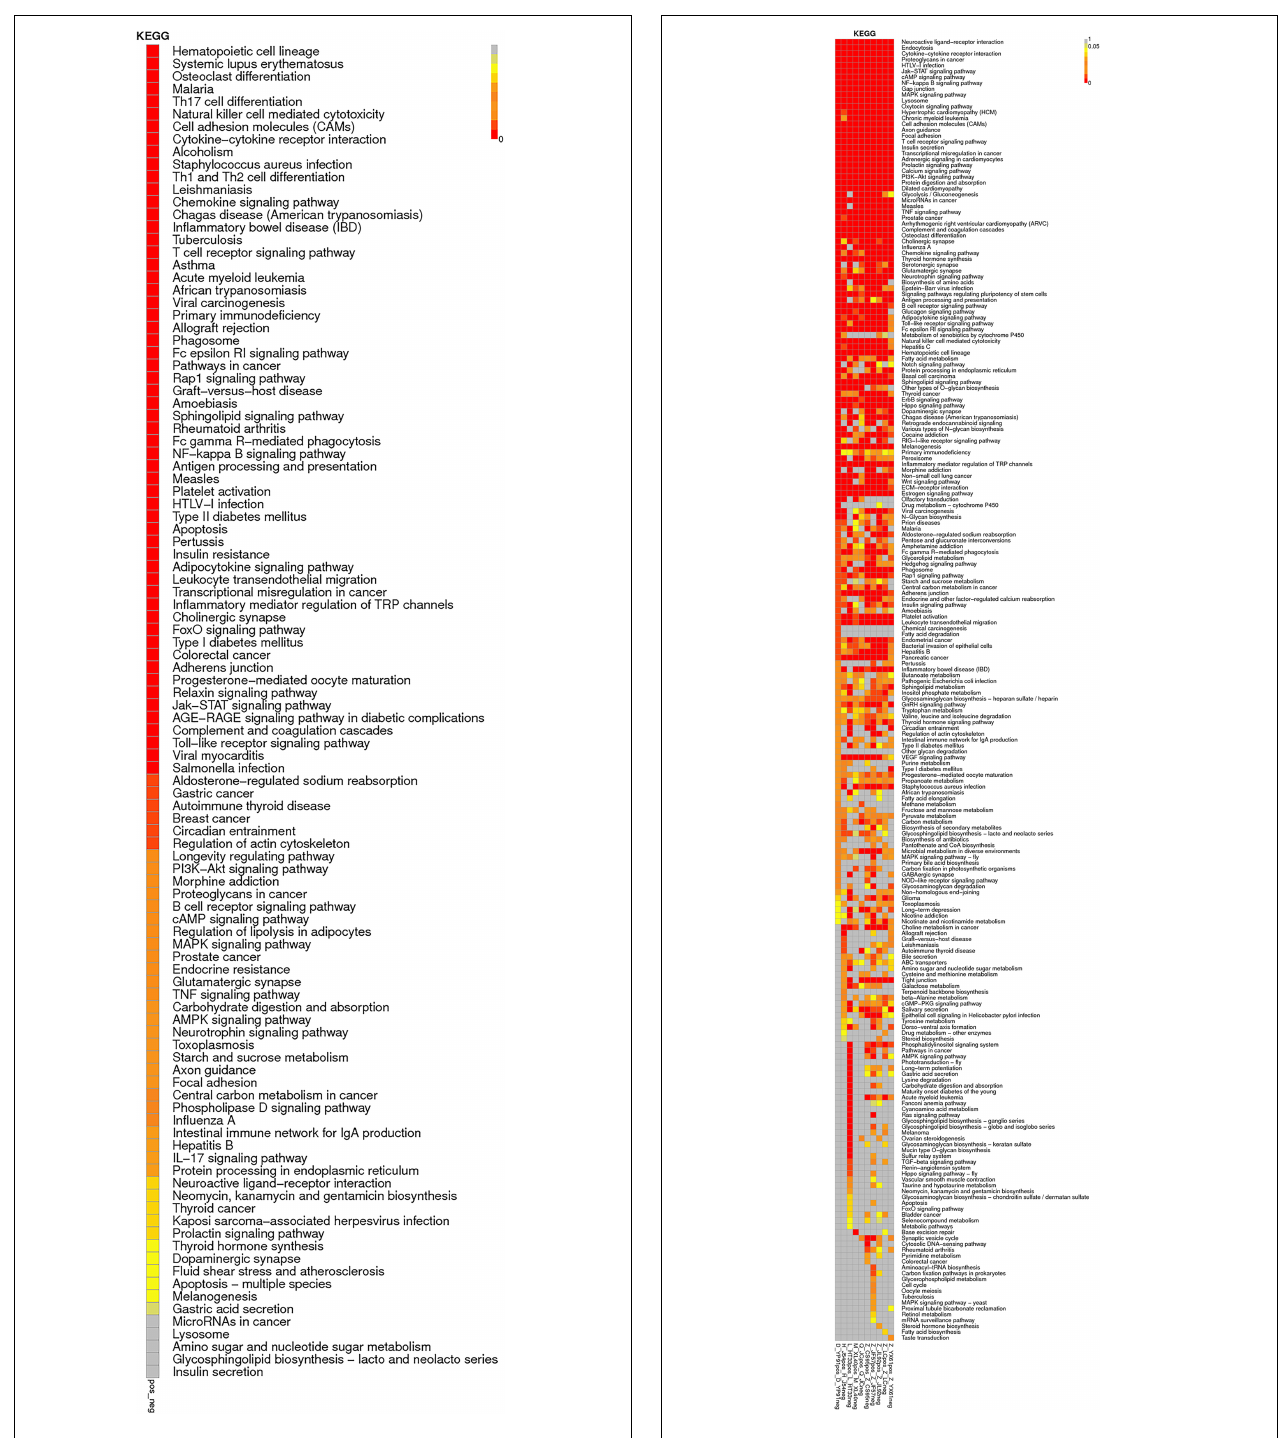
FIGURE 9 | KEGG pathway of lncRNAs:KEGG pathway scatterplots in the plasma cells of MM. The KO enrichment of all samples was combined, and the distribution map was drawn according to the significant Q -value of the enrichment of the samples. Each point indicates the degree of enrichment of the KO entry, and the closer the color approaches red, the higher the degree of enrichment is. The size of each point indicates the number of genes enriched in the KO entry. The larger the point is, the more the genes are enriched in the KO entry, and vice versa.